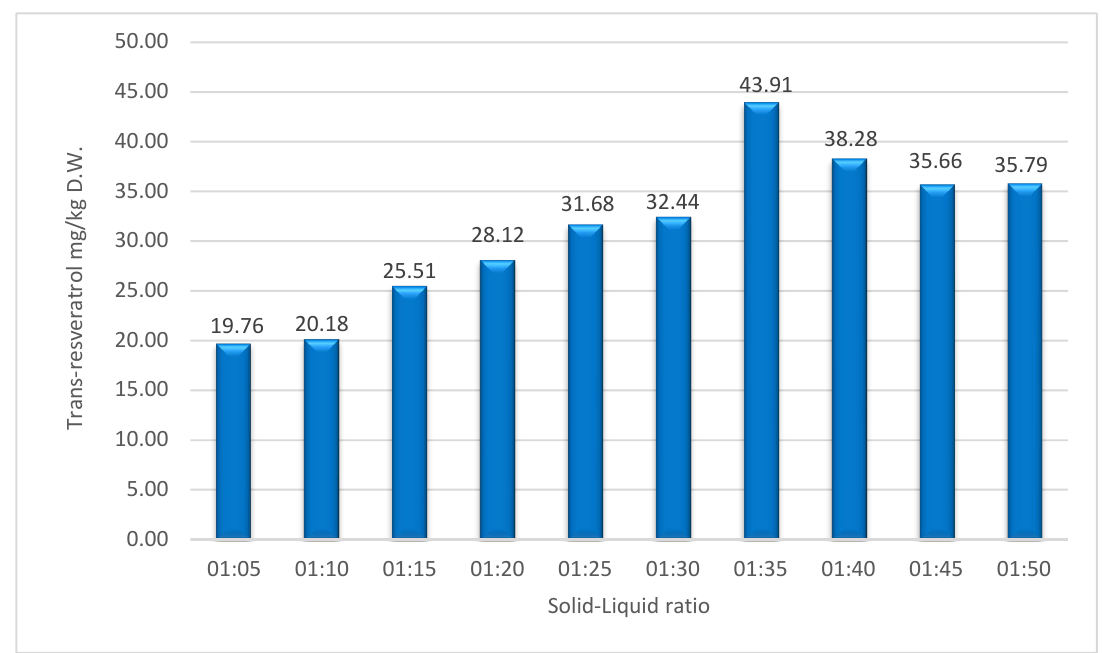
Figure 2. Extraction yield of resveratrol from vine shoots for different solid–liquid ratio.